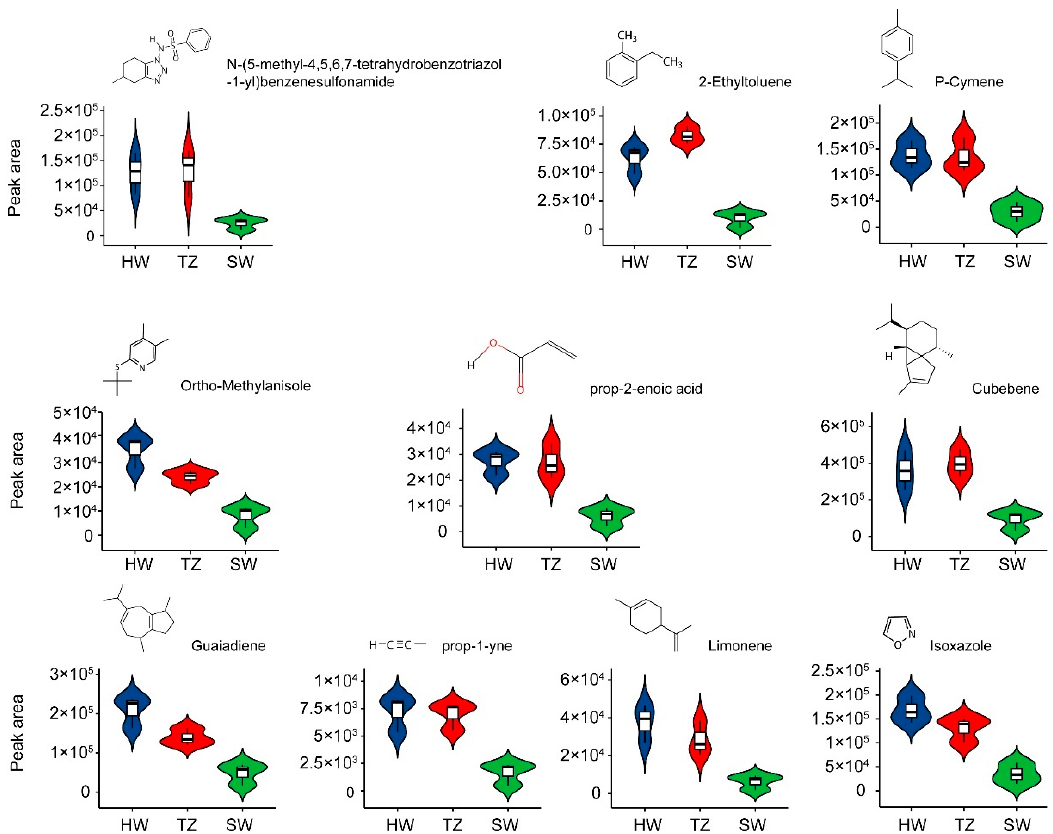
Figure 3. Structure and peak area of the top ten differential volatile metabolites related to fragrance.